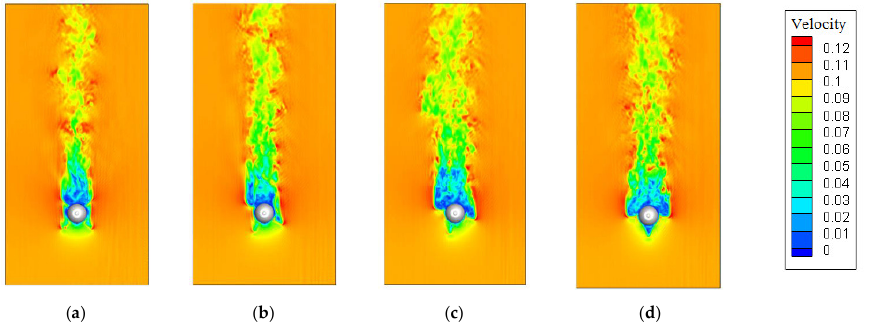
Figure 4. The schematic diagram of hydrodynamic simulations at different angles. ( a ) radian = 0 rad; ( b ) radian = 0.2618 rad; ( c ) radian = 0.5236 rad; ( d ) radian = 0.7854 rad.